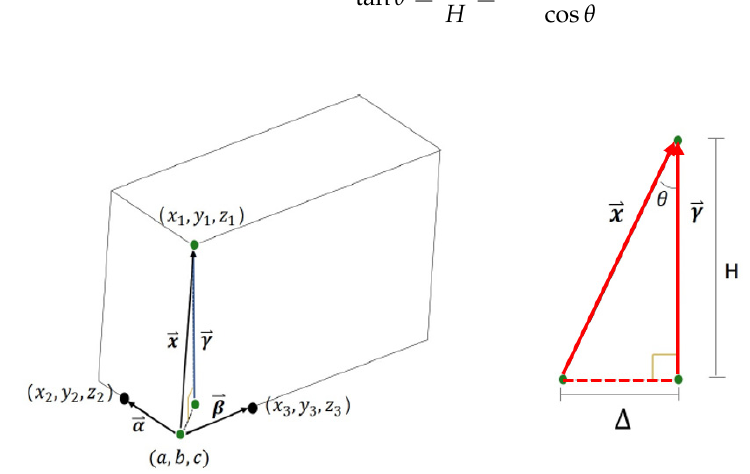
Figure 6. Tilt evaluation procedure adapted from Jeong.